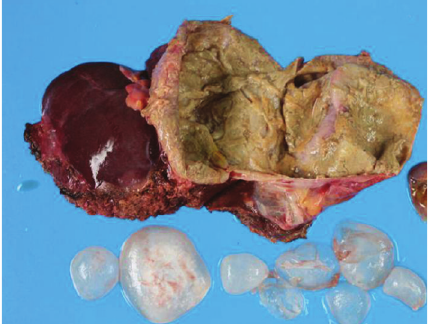
Figure 4: The resected specimen was a large cyst with a hard fibrous wall, which contained many small daughter cysts and watery fluid in their cavities.